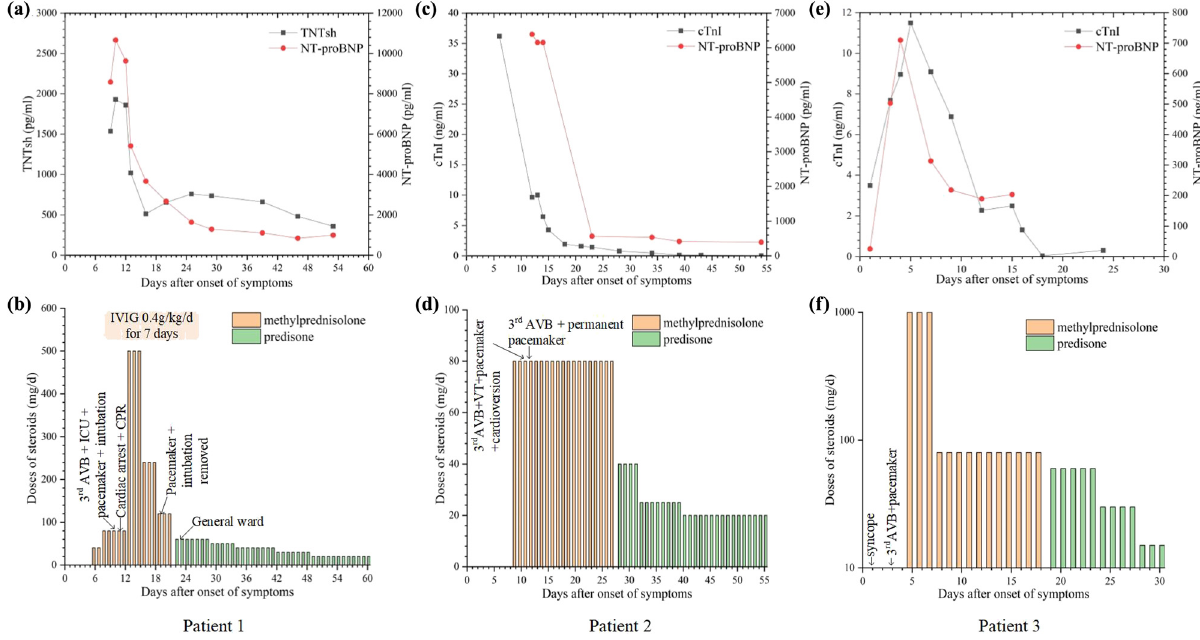
Figure 1: Clinical courses of three patients with immune - related myocarditis concomitant with complete AVB. ( a, c, e ) Cardiac biomarkers of three patients increased after developing myocarditis and gradually decreased with the initiation of therapy. ( b, d, f ) Doses of steroids over time and pacemaker implantation in three patients. TNTsh, high - sensitivity troponin T; NT - proBNP, n - terminal pro - brain natriuretic peptide; cTnI, cardiac troponin I; AVB, atrioventricular block; IVIG, intravenous immunoglobulin; and CPR, cardiopulmonary